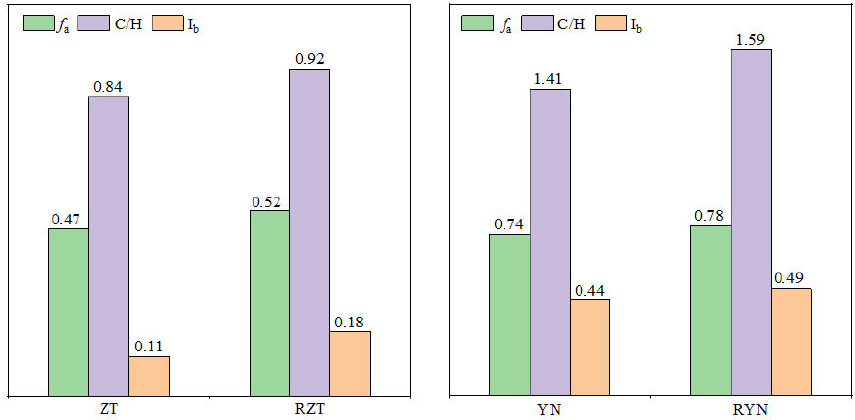
Figure 6. Organic structural parameters of coal